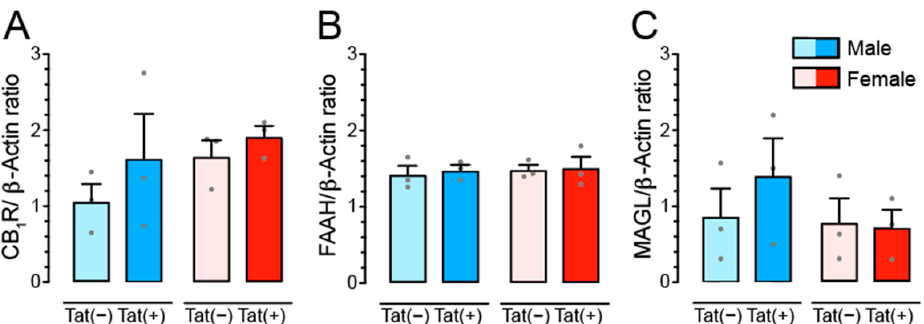
Figure 5. CB 1 R, FAAH, and MAGL protein expression levels are not altered by Tat and sex. Western blot analyses of protein expression levels for CB 1 R ( A ), FAAH ( B ), and MAGL ( C ) were assessed in the PFC of Tat transgenic mice. No significant effects were noted for any of the three measures. Data are eCB/ β -Actin ratio data (mean ± SEM) separated by sex and genotype. Statistical significance was assessed by ANOVA. Sample size: n = 3 mice per group and sex.